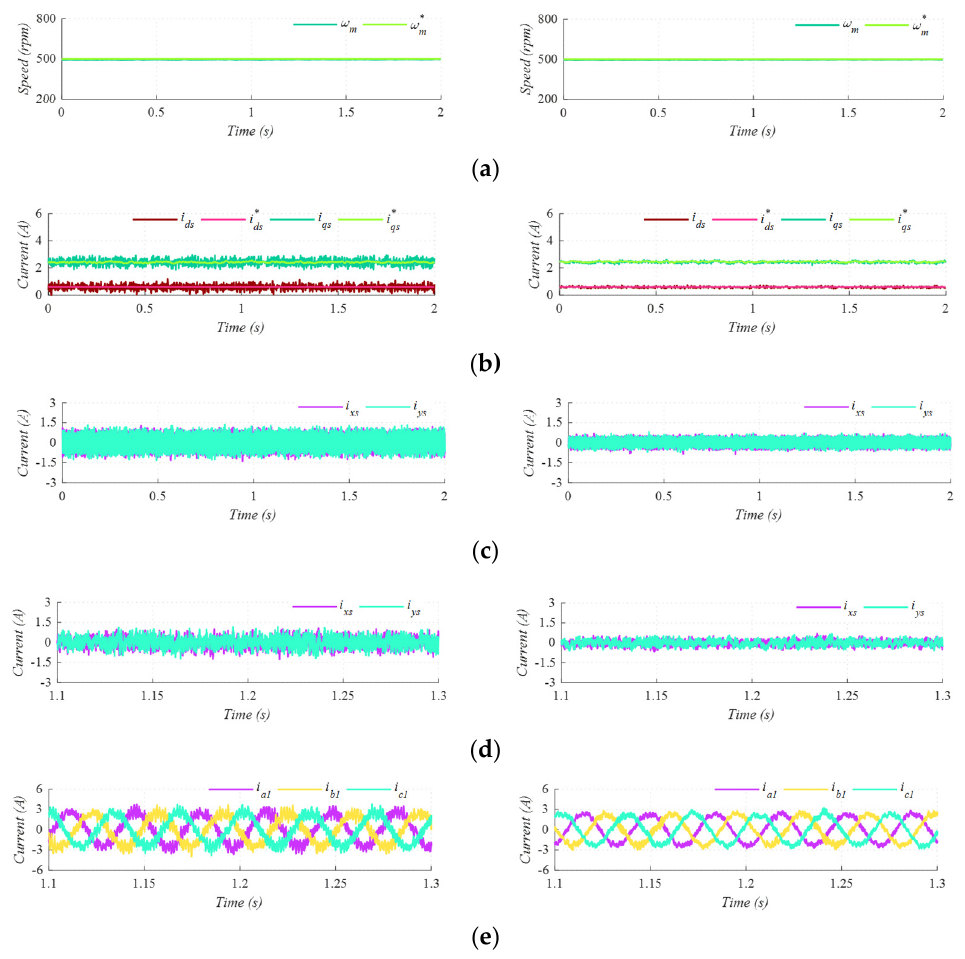
Figure 8. Test 2. Steady-state performance of LVV-MPC (left) and PULLA-MPC (right). From top to bottom: ( a ) motor speed, ( b ) 𝑑 - 𝑞 currents, ( c ) 𝑥 - 𝑦 currents, ( d ) zoom of the 𝑥 - 𝑦 currents and ( e ) set 1 of phase currents. Table 3. Quality indices and switching frequencies for Test 2.